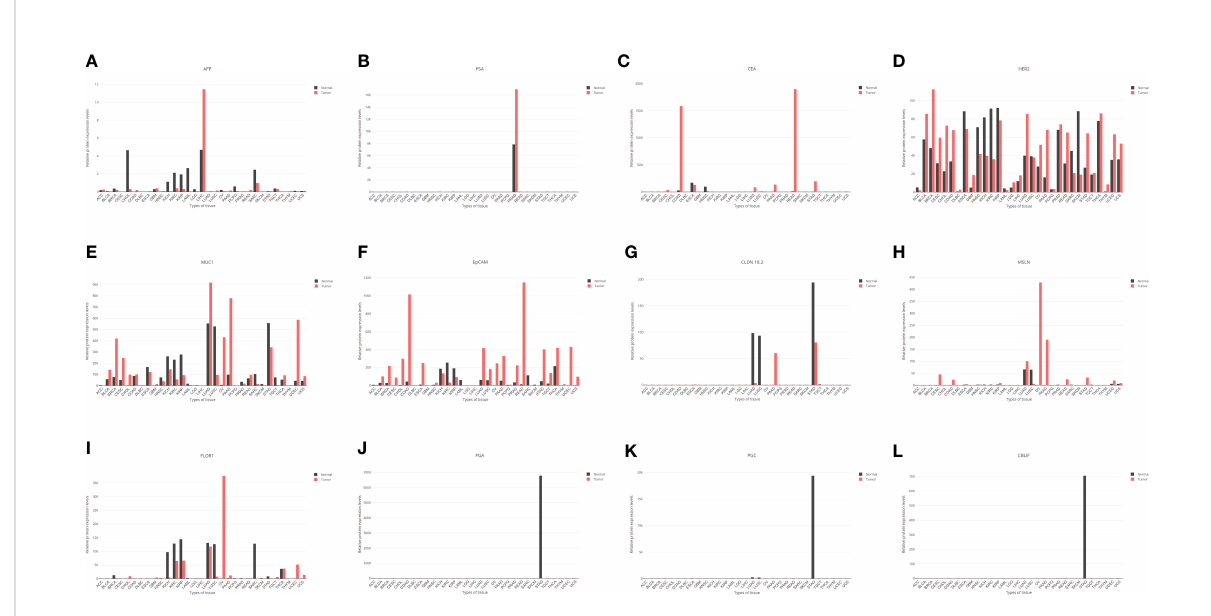
FIGURE 5 The expression levels of some genes in various tissues based on the GEPIA online database (http://gepia.cancer-pku.cn/index.html). AFP, alpha- fetoprotein; LIHC; liver hepatocellular carcinoma; PSA, prostate-speci fi c antigen; PRAD, prostate adenocarcinoma; STAD, stomach adenocarcinoma; CEA, carcinoembryonic antigen; COAD, colon adenocarcinoma; READ, rectum adenocarcinoma; LUAD, lung adenocarcinoma; HER2, human epidermal growth factor receptor 2; MUC1, mucin 1; EpCAM, epithelial cell adhesion molecule; CLDN 18.2, claudin 18.2; MSLN, mesothelin; FOLR1, folate receptor 1; PGA, pepsinogen; PGC, gastricsin; CBLIF, cobalamin binding intrinsic